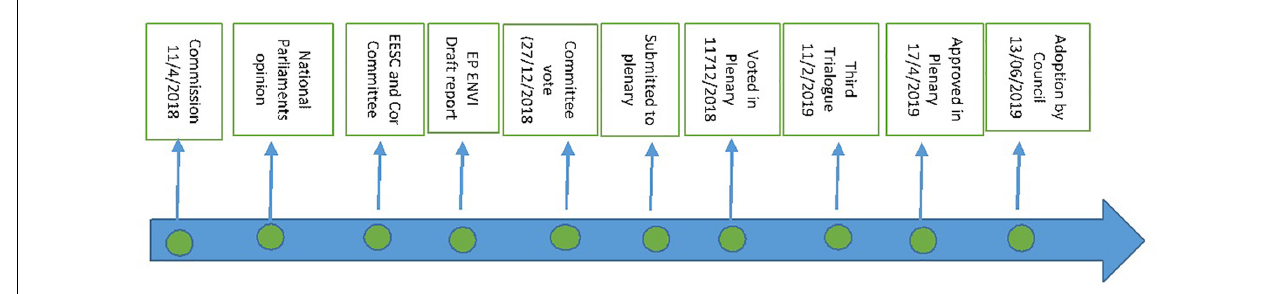
FIGURE 2 | Procedure on Commission’s legislative proposal after it was submitted to EP and